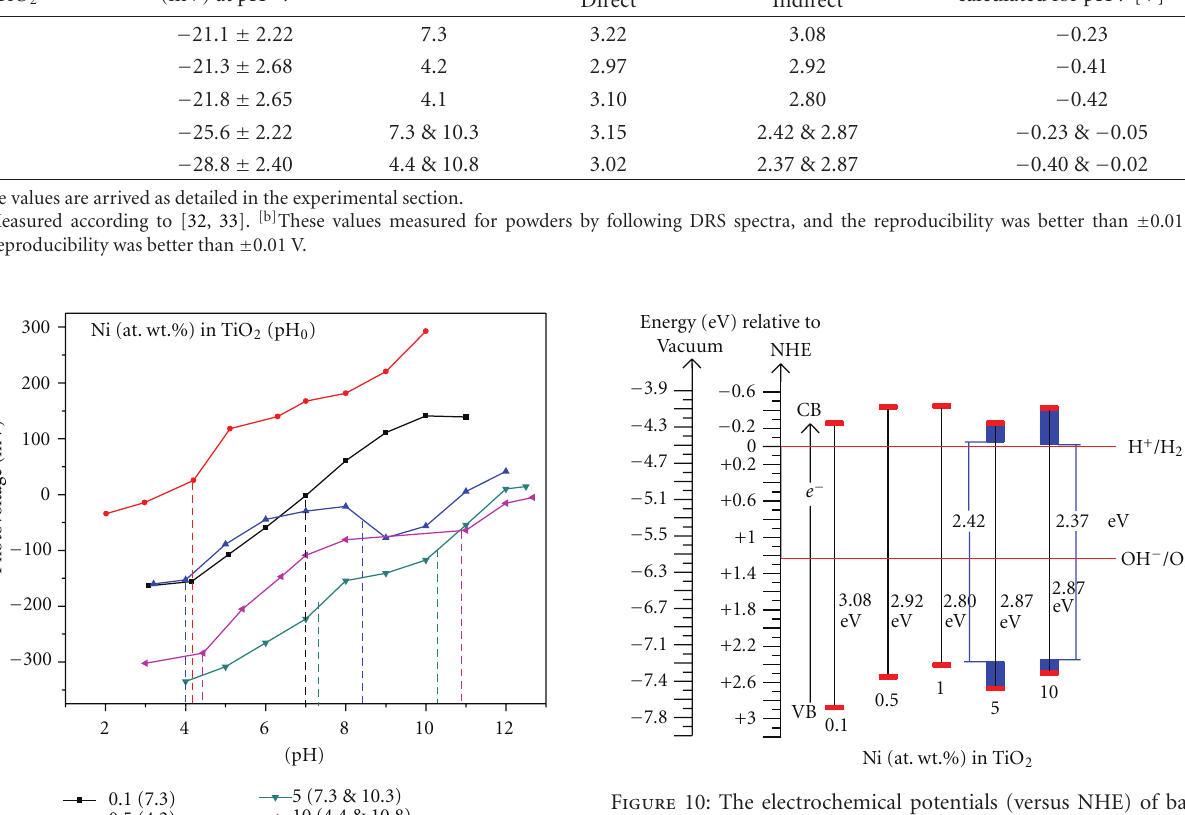
Table 2: Photoelectrochemical and band-gap energy data of Ni-doped TiO 2 (Ni = 0.1, 0.5, 1, 5, and 10 at. wt.%) powders formed at 550 ◦ C for 6 h. † Ni (at. wt.%)